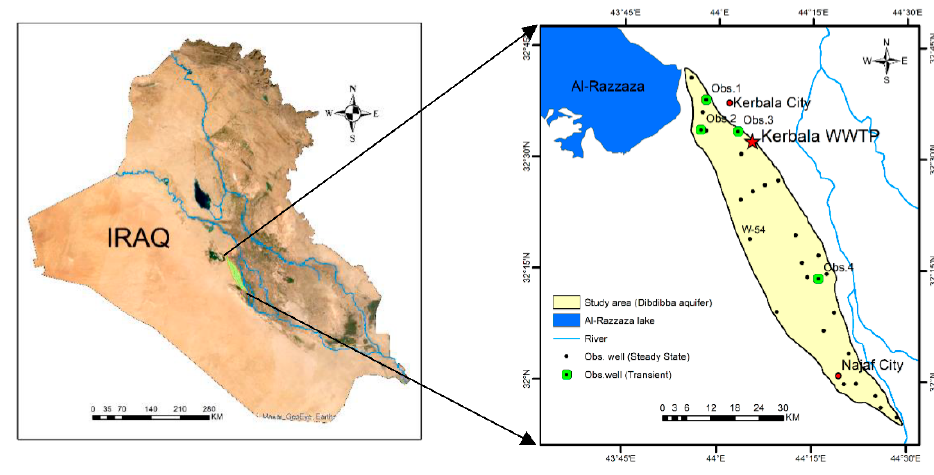
Figure 1. Location of the study area with the Kerbala WWTP.